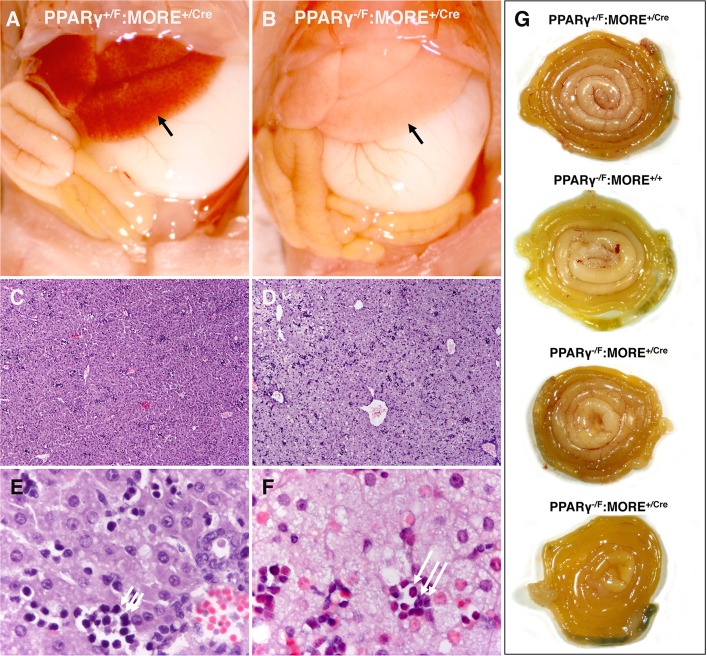
Hepatic steatosis and normal bowel in PPARγ-/F:MORE+/Cre neonatal mice.(A and B) The abdominal contents reveal pale, enlarged liver (arrows) in P3 PPARγ-/F:MORE+/Cre mice (B) compared to normal controls (A). (C-F). H & E histology of the liver reveals microvessicular steatosis and focal hepatitis in mutant mice (D and F) but absence of steatosis or inflammation and presence of normal extramedullary hematopoiesis in control mice (C and E). Short and long arrows in E and F distinguish normal extramedullary hematopoiesis (E) from acute inflammation (F with neutrophils) in control (E) and PPARγ-/F:MORE+/Cre (F) mice, respectively. (G) Gastrointestinal tracts were dissected from duodenum to rectum, loosely coiled on a flat surface with duodenum central and rectum peripheral, and photographed. PPARγ-deficient small and large bowel is normal without evidence of ischemia, hemorrhage, inflammation or necrosis.